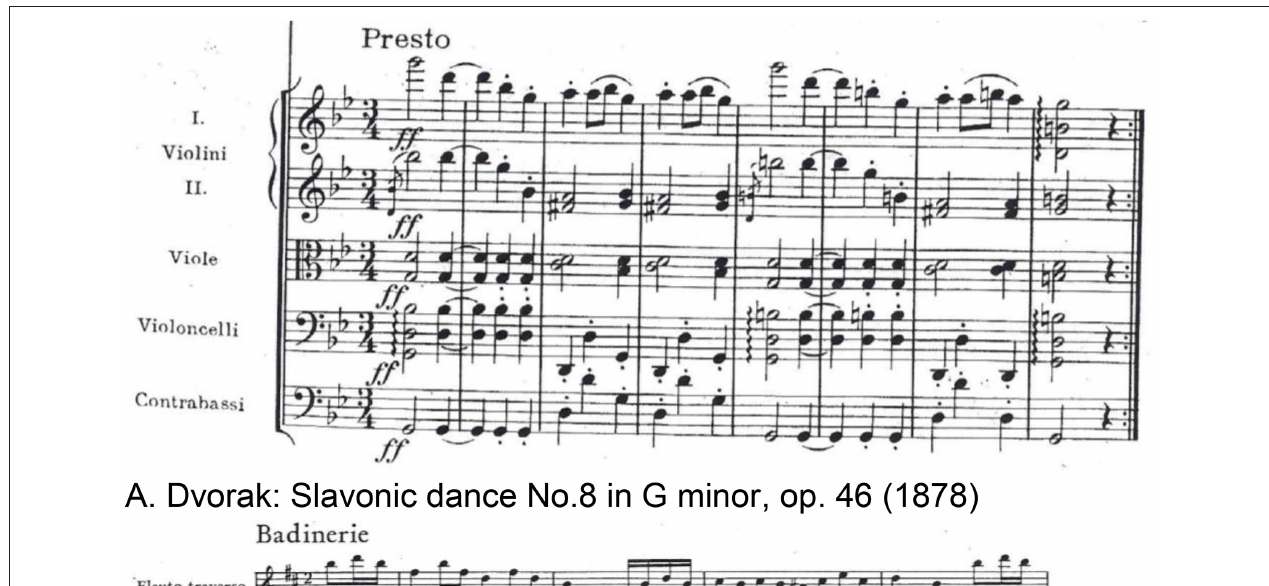
Frontiers in Neuroscience |